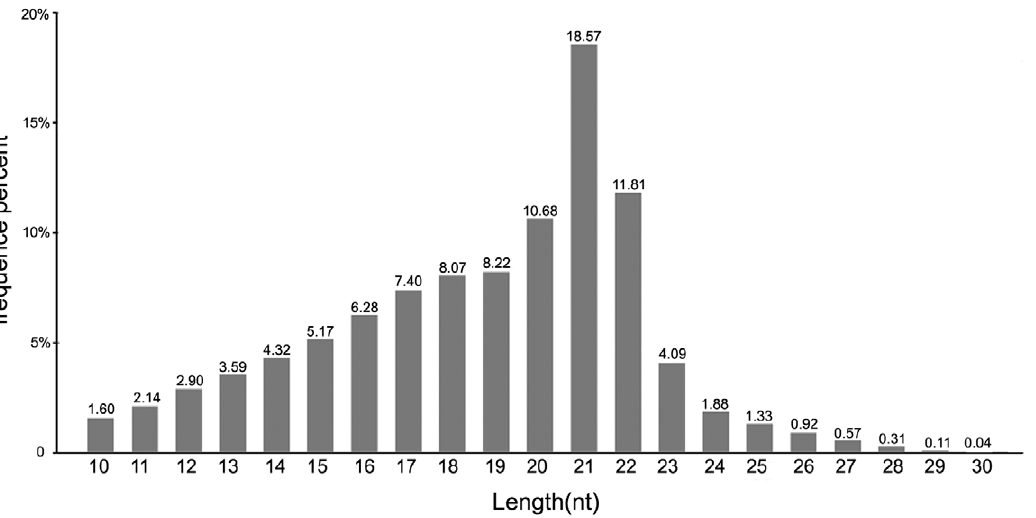
Figure 1. Lengths of unique small RNA sequences in P.yezoensis . The occurrences of each unique sequence reads was counted to reflects relative expression level and only small RNA sequences in the range of 10 to 30 nt were considered.